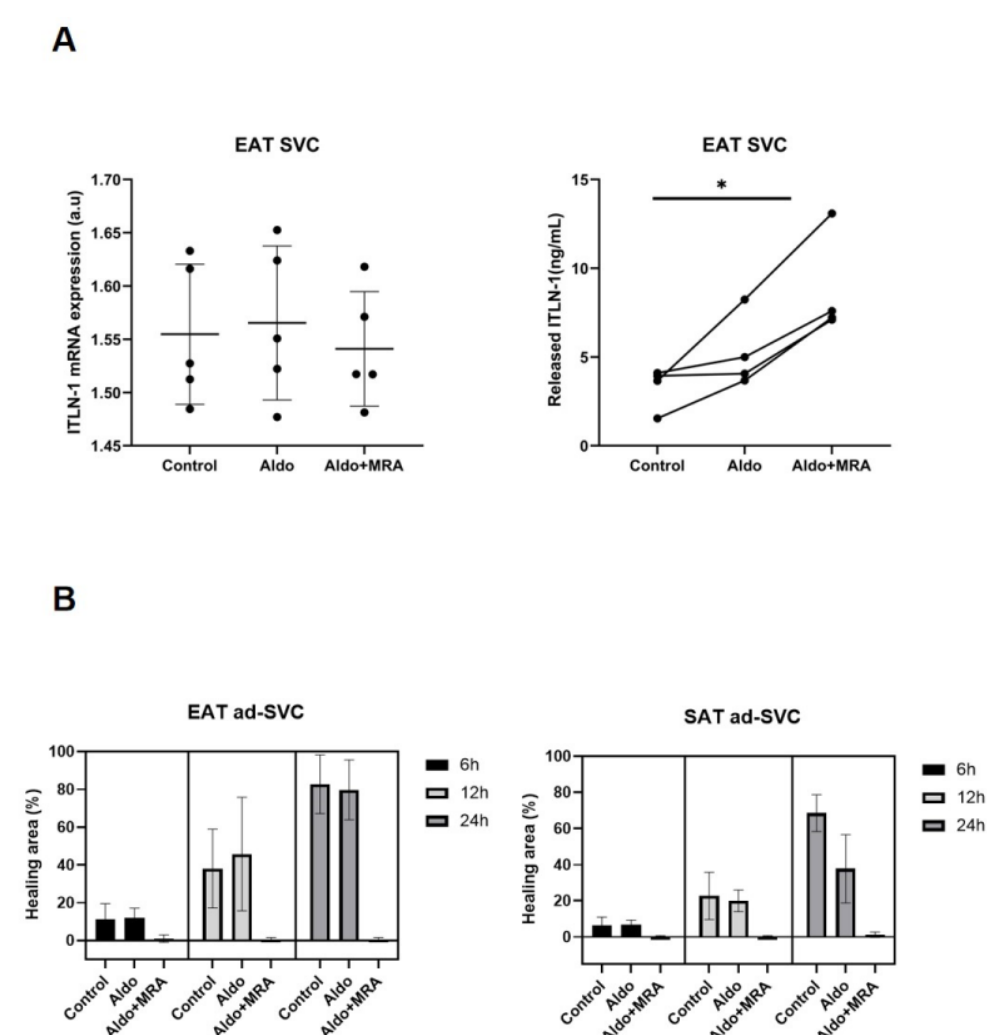
Figure 6. ITLN-1 in epicardial stromal cells and MRA ( A ) Dot plots and mean ± SD represent the released ITLN-1 levels (ng/mL) or mRNA expression levels of ITLN-1 in epicardial fat stromal cells treated or not treated with aldosterone and MRA ( B ) Wound healing assay. Bar plots and mean ± SD represents percentage of healing area of dedifferentiated epicardial and subcutaneous adipocytes (ad-SVC) with or without aldosterone and MRA treatment. ANOVA t test showed statistical differences among groups and Bonferroni post hoc test showed differences between control and MRA treatment * p < 0.05.